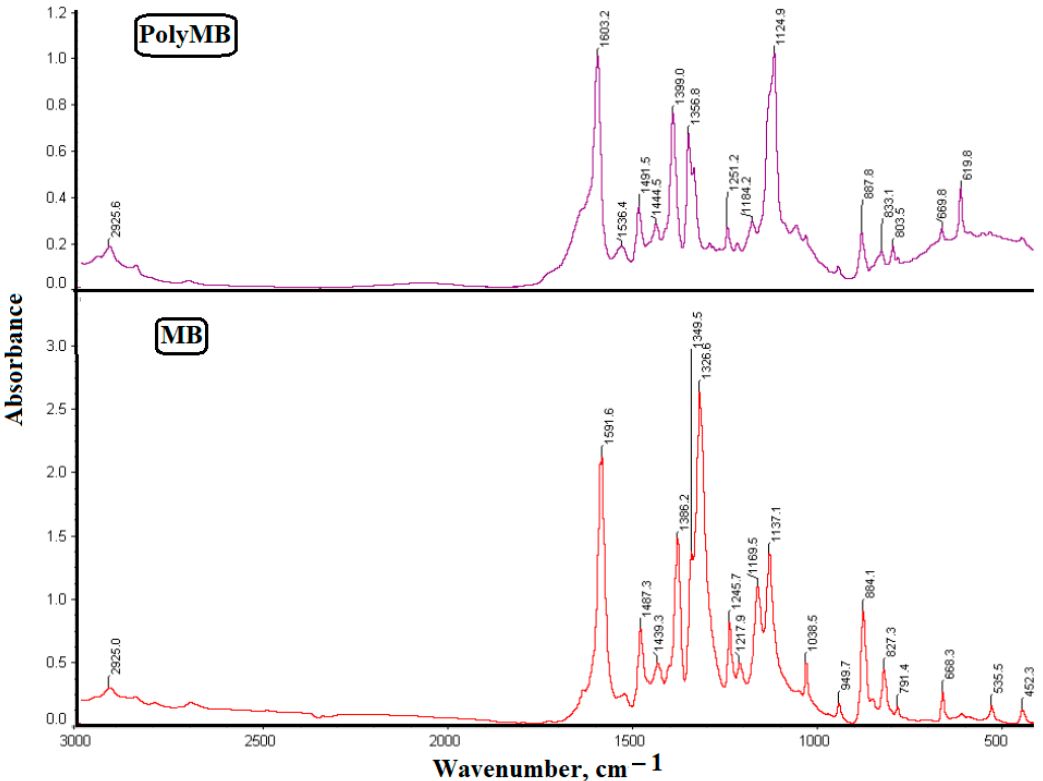
Figure 8. IR spectra: MB—methylene blue; PolyMB—polymethylene blue, recorded in potassium bromide tablets.